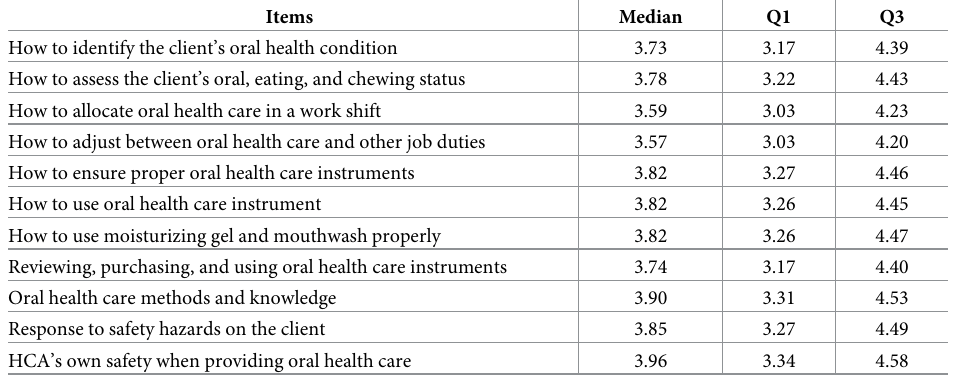
Table 5. HCAs’ intention to receive professional training in oral health care.